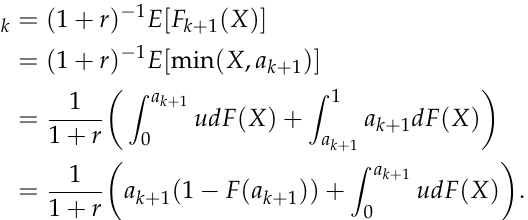
Figure 2. The values of the decision scalars { a k } n distribution of the load for different delay factors r